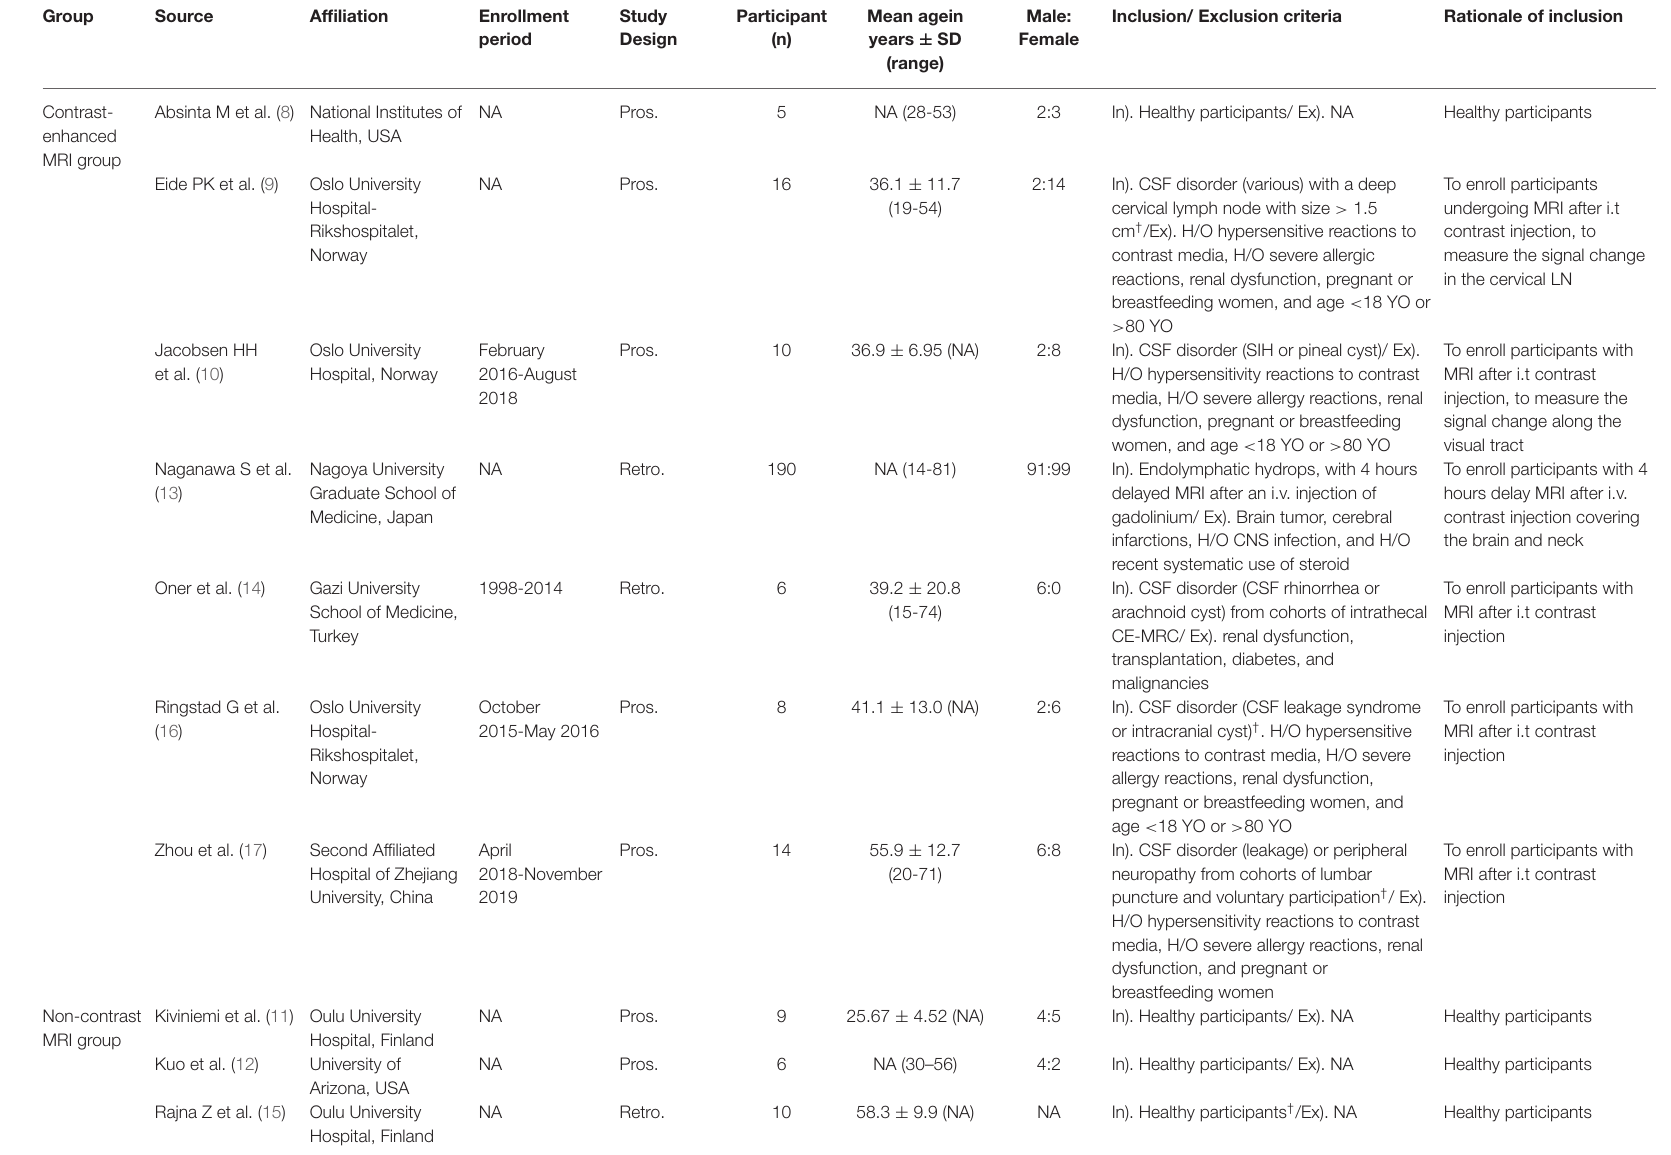
TABLE 1 | The clinical characteristics of the included studies. Group Source Male: